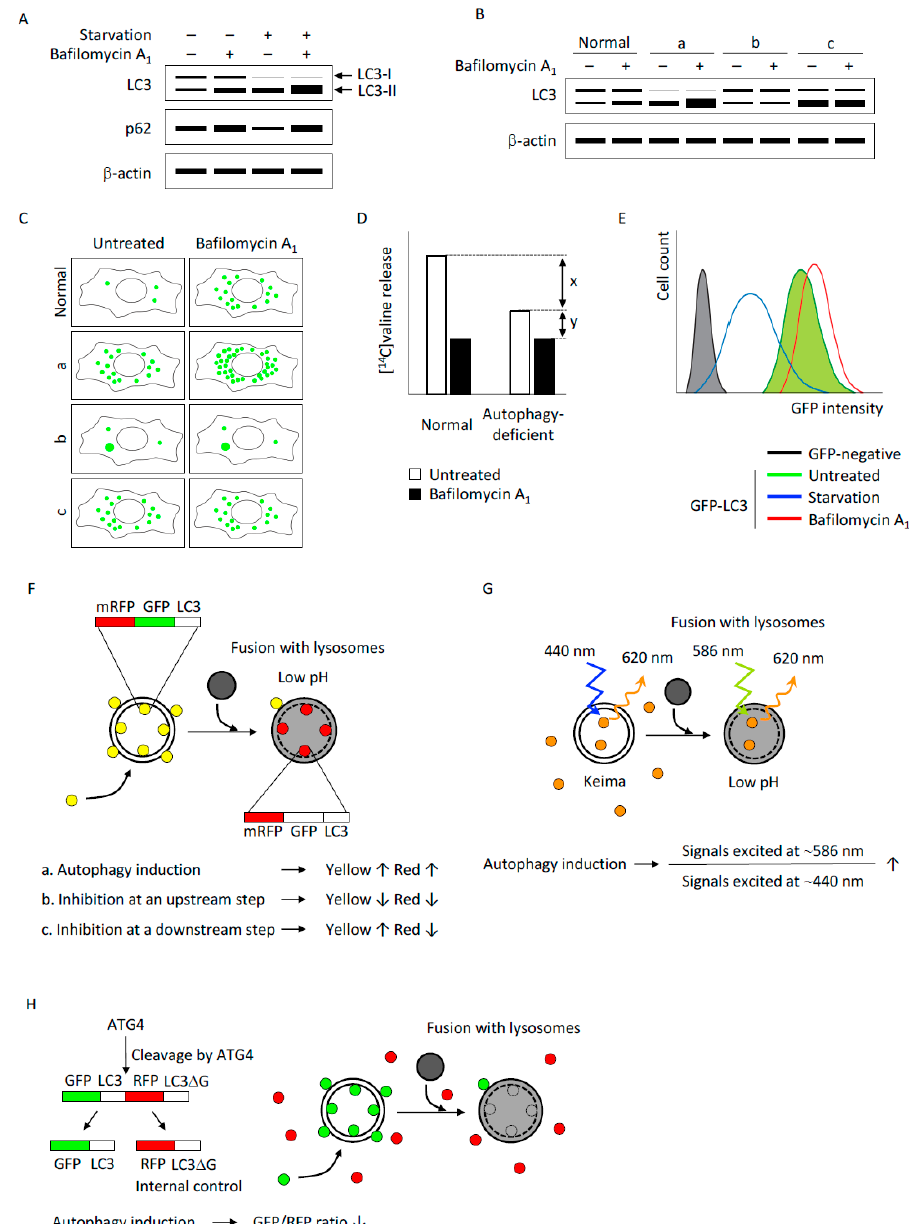
Figure 2. ( A ) A schematic illustration of detection of autophagic flux by immunoblotting. Both LC3-II and p62 are degraded by autophagy; therefore, the amounts of LC3-II and p62 degraded by autophagy, but not their expression levels, provide an estimate of the autophagic activity. Typically, autophagy induction, for instance by nutrient starvation, converts LC3-I to LC3-II and induces an increase in LC3-II and a concurrent decrease in p62. Inhibition of lysosomal degradation by bafilomycin A 1 causes accumulation of LC3-II and p62, and this increment reflects the amount of LC3-II and p62 that would have been degraded by autophagy over the treatment period; ( B ) A schematic illustration of the interpretation of LC3 immunoblotting results. Autophagic flux in normal cells is estimated by an increase in the LC3-II amount under bafilomycin A 1 treatment. Group “a” has an increased amount of LC3-II in the basal state, which further increases in the presence of bafilomycin A 1 , suggesting increased autophagic flux in these cells. Group “b” has a low level of LC3-II under basal conditions and does not respond to bafilomycin A 1 treatment, suggesting that autophagy is suppressed in these cells. Group “c” has a large amount of LC3-II under basal conditions, which does not increase by bafilomycin A 1 treatment, suggesting decreased autophagic flux (e.g., by a defect in lysosomal degradation)